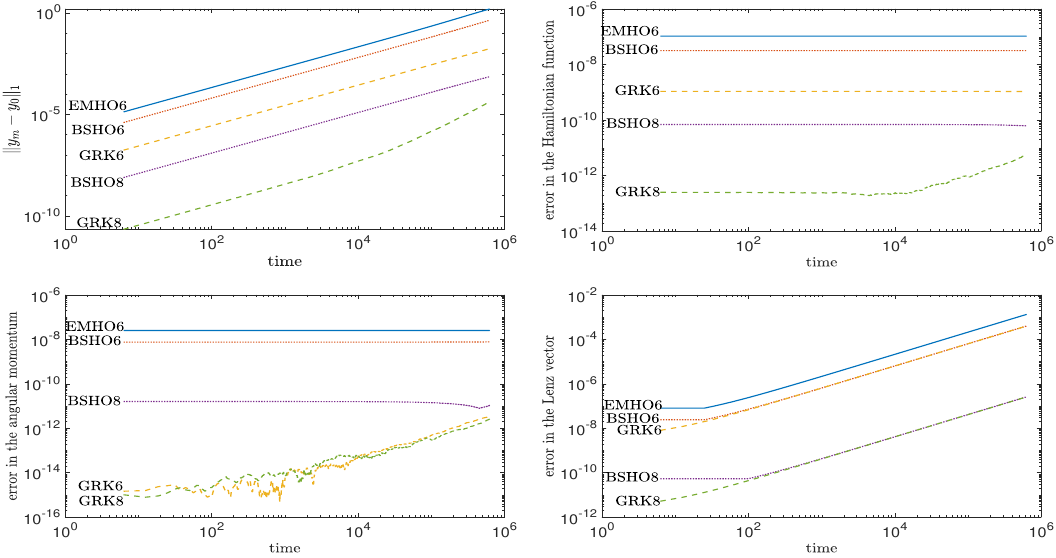
Figure 2. Kepler problem: results for the sixth (BSHO6, red dotted line) and eighth (BSHO8, purple dotted line) order BSHO methods, sixth order Euler–Maclaurin method (EMHO6, blue solid line) and sixth (Gauss–Runge–Kutta (GRK6), yellow dashed line) and eighth (GRK8-green dashed line) order Gauss methods. ( Top-left ) Absolute error of the numerical solution; ( Top-right ) error in the Hamiltonian function; ( Bottom-left ) error in the angular momentum; ( Bottom-right ) error in the first component of the Lenz